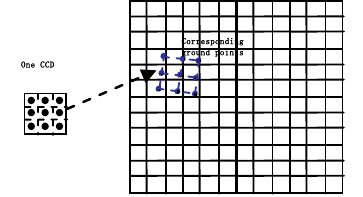
Figure 3. Sub-CCDs and corresponding ground